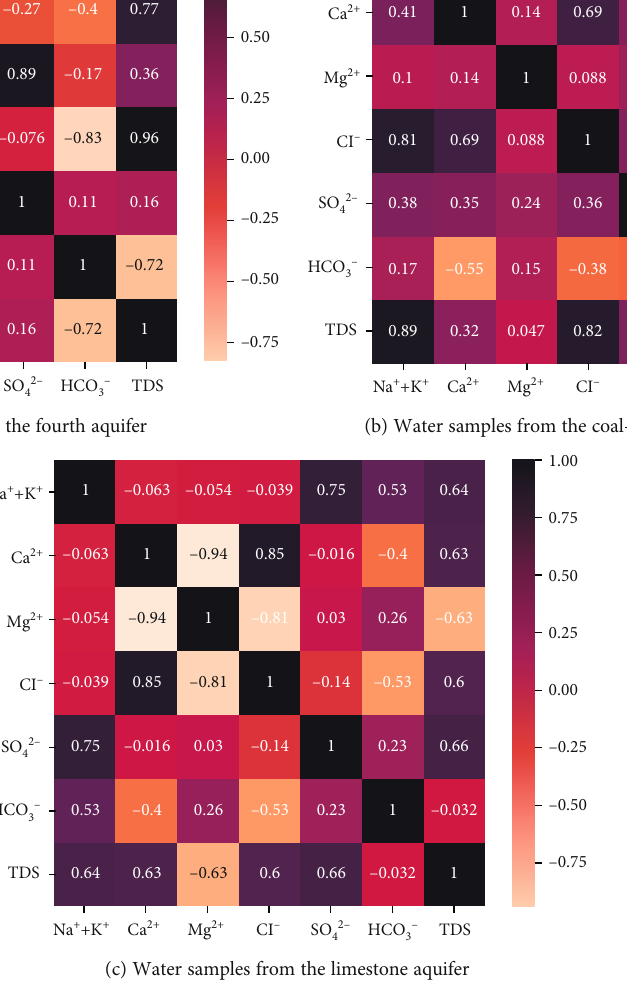
Figure 4: Heat maps of hydrochemical composition correlation coe ffi